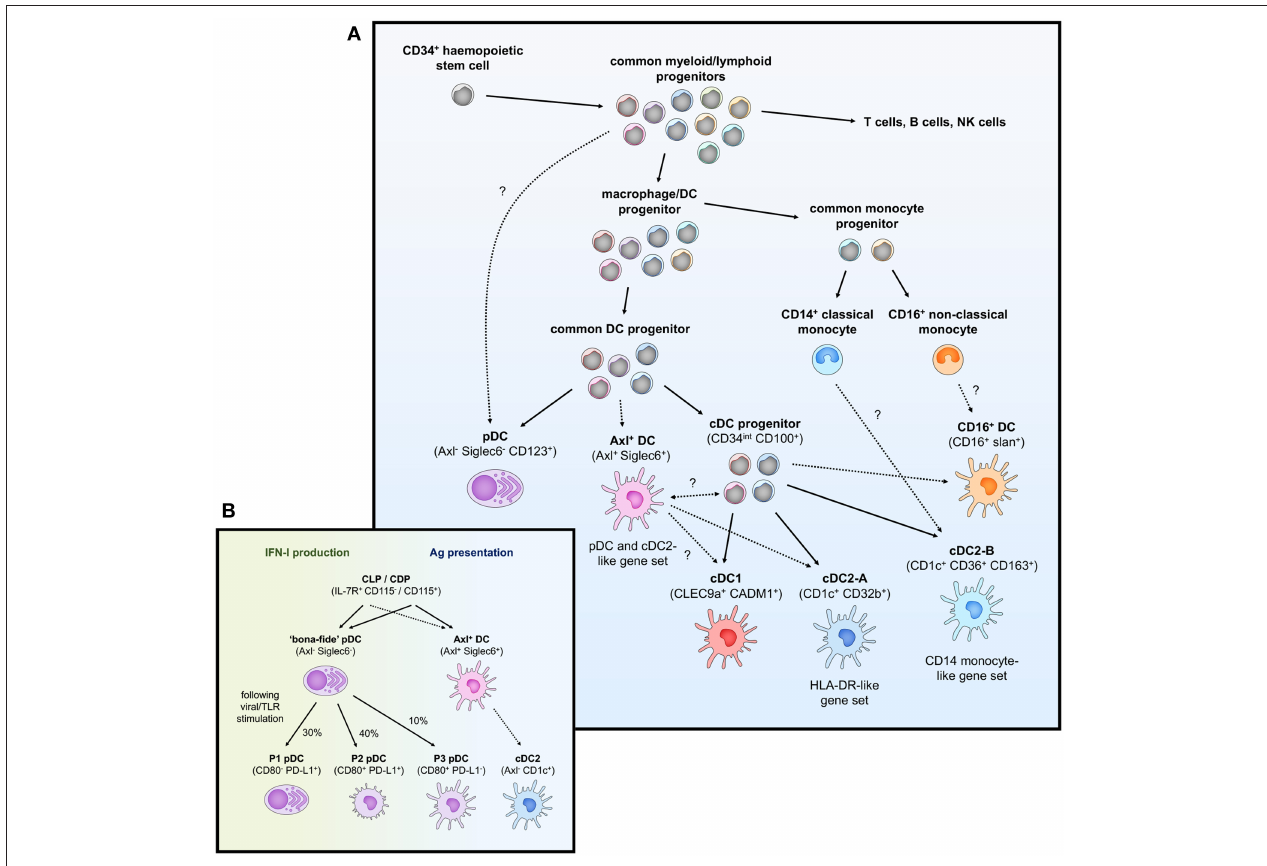
FIGURE 1 | Overview of peripheral blood DC subsets and ontogeny. (A) Highly proliferative and self-renewing CD34 + hematopoietic stem cells produce early progenitors each primed toward distinct cell fates. These progenitors pass through several shared phenotypes to create heterogenous populations of macrophage/DC progenitors, common DC progenitors, cDC progenitors to eventually generate functional DCs (pDCs, Axl + DCs, cDC1, cDC2-A, cDC2-B, and CD16 + DC). Whether these DCs represent fully-differentiated cells is contentious—Axl + DCs have been separately described to be a fully functional end-stage cell, be capable of acquiring a cDC2-like phenotype, or represent a more mature cDC progenitor that can further differentiate into cDC1 and cDC2. Their relationship to a primitive cDC progenitor (CD34 int CD100 + ) is also not clear. The relationship between cDC2-B and CD16 + DC with monocytes is also ambiguous at the present time. (B) pDCs (CD123 + BDCA2 + ) have previously been ascribed both IFN-I production and antigen (Ag) presentation properties. The identification of Axl + DCs which also express typical pDC markers has clarified these functions, which can now be separately attributed to Axl − pDCs and Axl + DCs, respectively. However, Axl − pDCs can also differentiate into Ag-presenting pDCs following stimulation (P2 and P3 pDCs) that have limited capacity for IFN-I production, creating some complication for accurately demarcating cells with IFN-I ability and T cell stimulation in the CD123 + population.